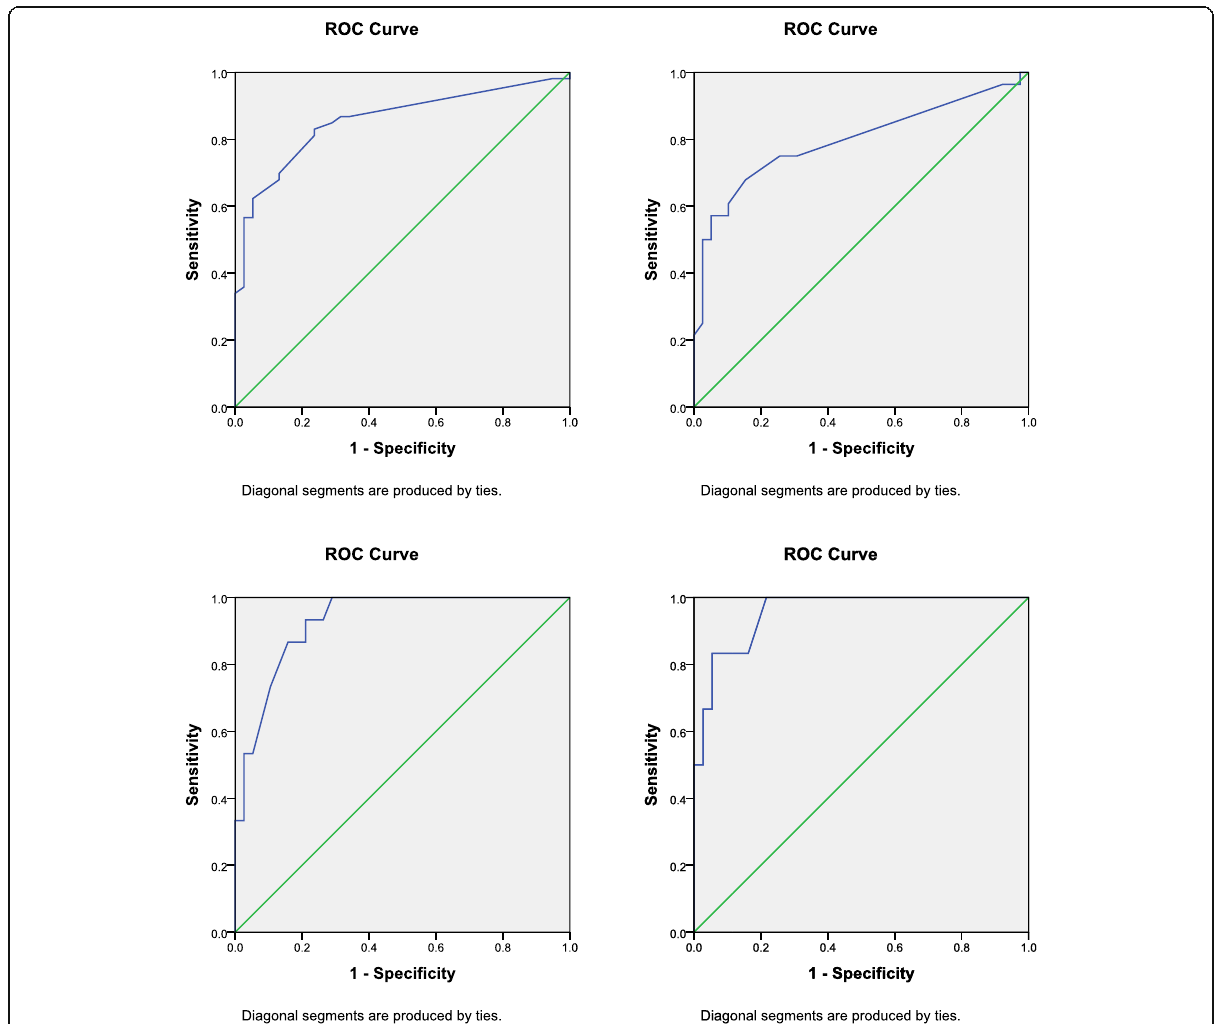
Fig. 1 Receiver Operating Curve (ROC Curve) of stable (GROC-NP 4) Vs improved groups (GROC-NP 5, 6, 7)